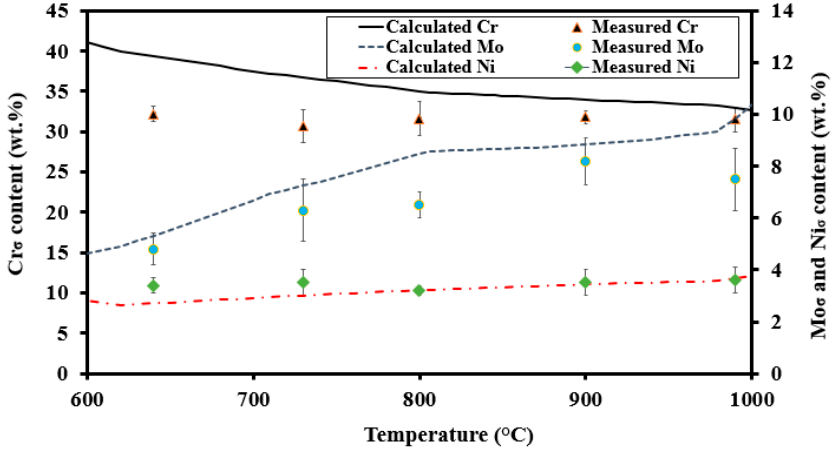
Figure 14. Measured (EDS) and calculated (JMatPro) Cr, Mo, and Ni content of sigma phase precipitated at different temperatures.